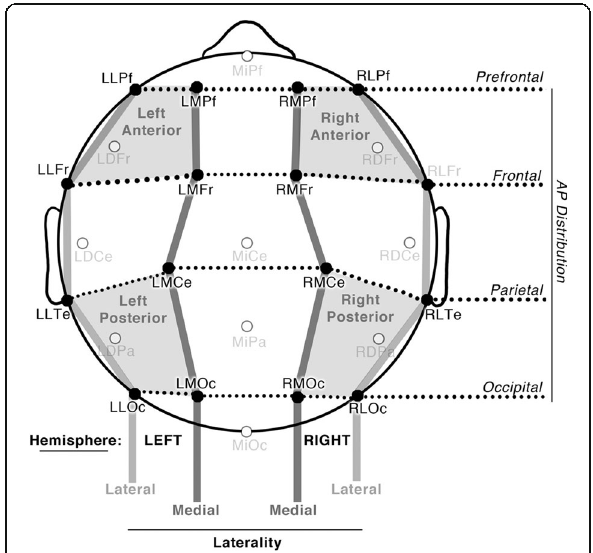
Fig. 4 Electrode montage, illustrating 16 electrode sites analyzed across Hemisphere, Laterality, and Anterior – Posterior ( AP ) Distribution, as well as Quadrants used in follow-up analyses. Fr frontal, L left, L lateral, M medial, Oc occipital, Pa parietal, Pf prefrontal, R right, Mi Midline, Ce Central, Te